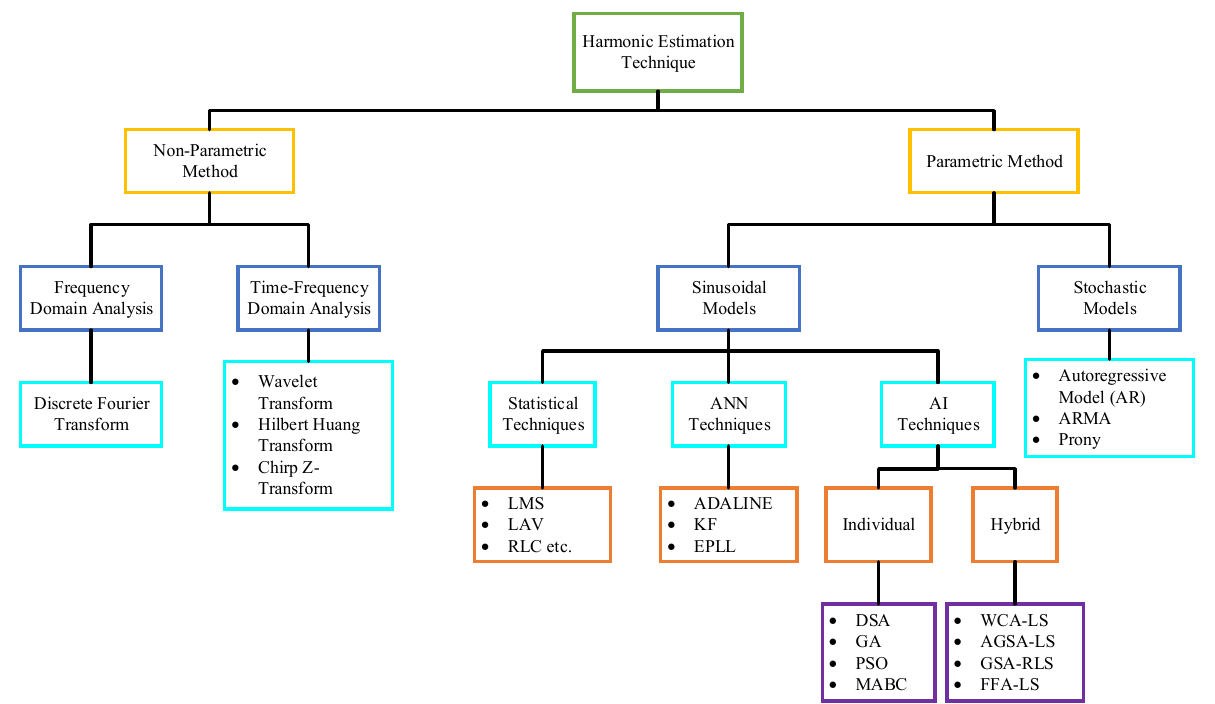
Figure 1. Classification of methodologies used for HE problem.